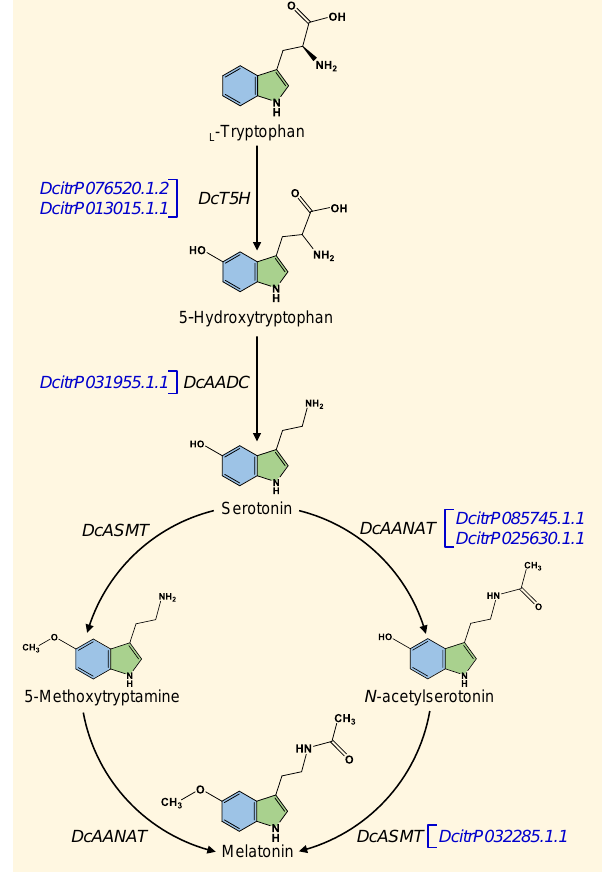
Figure 16. Proposed melatonin biosynthesis pathway in Diaphorina citri and its associated genes. The listed putative gene candidates were identified based on the top-matches of recent available data on the “ Diaphorina citri OGS v2.0 proteins” dataset available on the citrus greening solutions website (https://citrusgreening.org/organism/Diaphorina_citri/genome, 12 February 2021). DcT5H : Tryp- tophan 5-hydroxylase, DcAADC : Aromatic amino acid decarboxylase, DcAANAT : Arylalkylamine N-acetyltransferase, and DcASMT : N -acetylserotonin